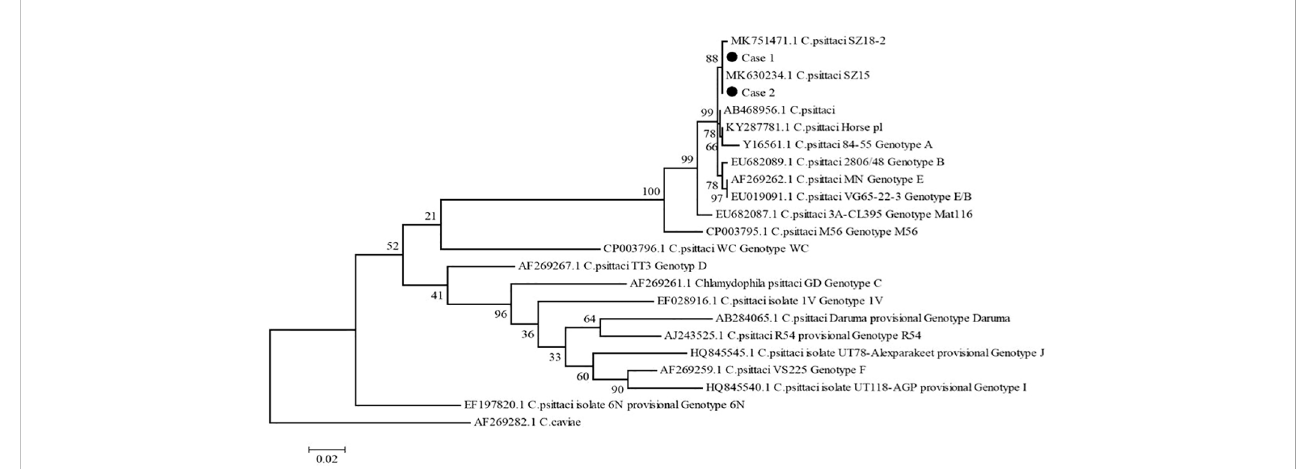
FIGURE 2 Phylogenetic tree of C. psittaci ompA gene sequences. The tree was constructed using the maximum-likelihood method based on GTR model, with 1,000 bootstrap replicates in MEGA5, compared with reference sequences available in the GenBank database (GenBank accession number indicated). C. caviae (AF269282.1) was used as an out-group. Black dots indicate isolates from this study. Numbers at nodes indicate bootstrap values. Scale bar indicates nucleotide substitutions per